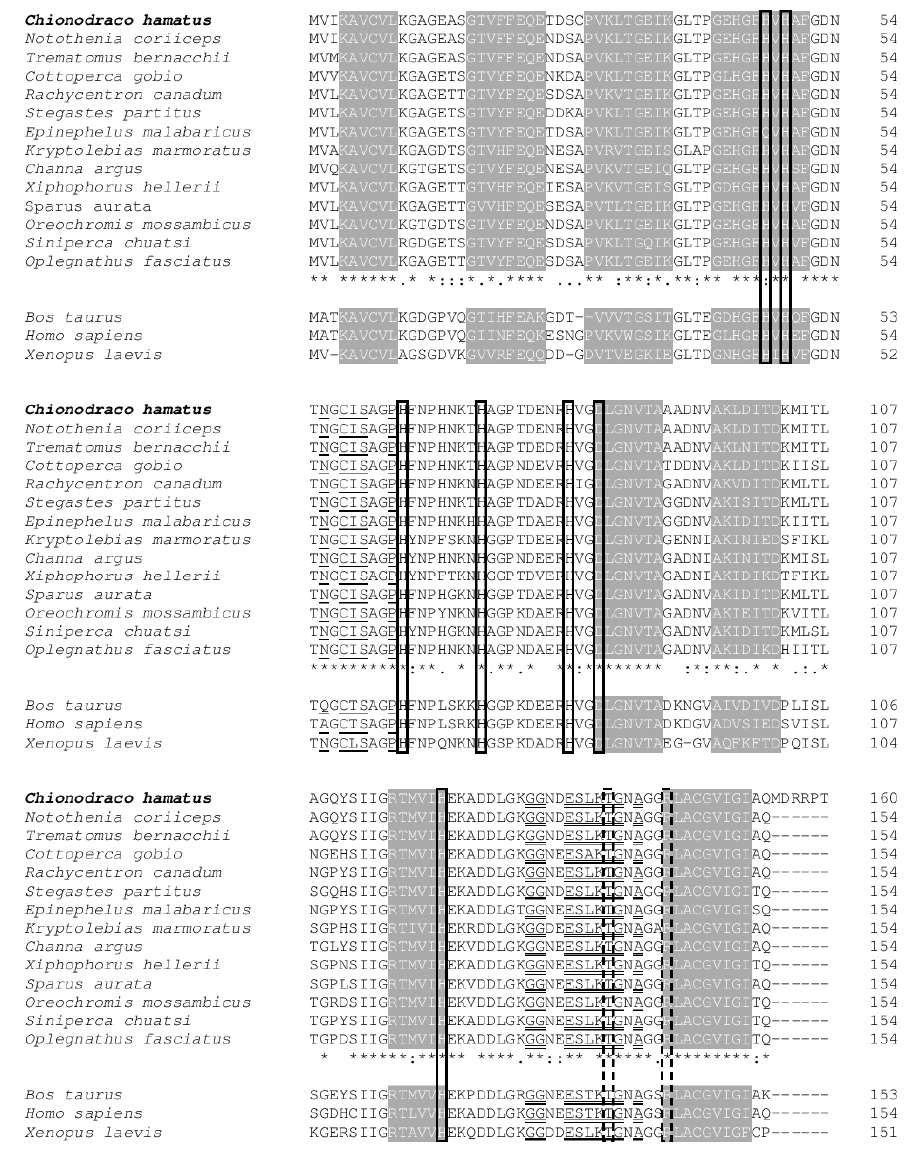
Figure 2. Multiple alignment of amino acid sequences of 14 SOD1s from teleost species, as well as from Xenopus laevis , Bos Taurus, and Homo sapiens . The shaded letters refer to the β-strand conformation of the bovine structure. Unshaded letters between β-strand regions refer to the 7 loops. The boxed letters refer to the amino acids that play an important role in the Cu 2+ –Zn 2+ coordination environment (solid line) and in the active site region (dotted line). Underlined and double-underlined letters refer to the amino acids that play important roles in the formation of the lower and upper rims, respectively. The symbols at the bottom of the teleost sequences correspond to the definitions in the MUSCLE program: (*) fully conserved; (:) highly conserved; (.) conserved